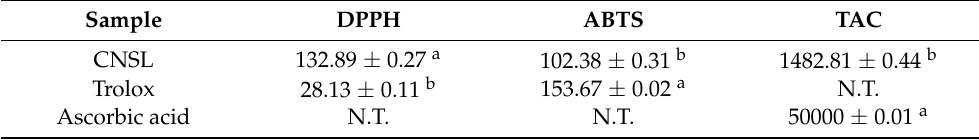
Table 4. Antioxidant activity expressed as the IC 50 ( µ g/mL) of cashew nut shell liquid